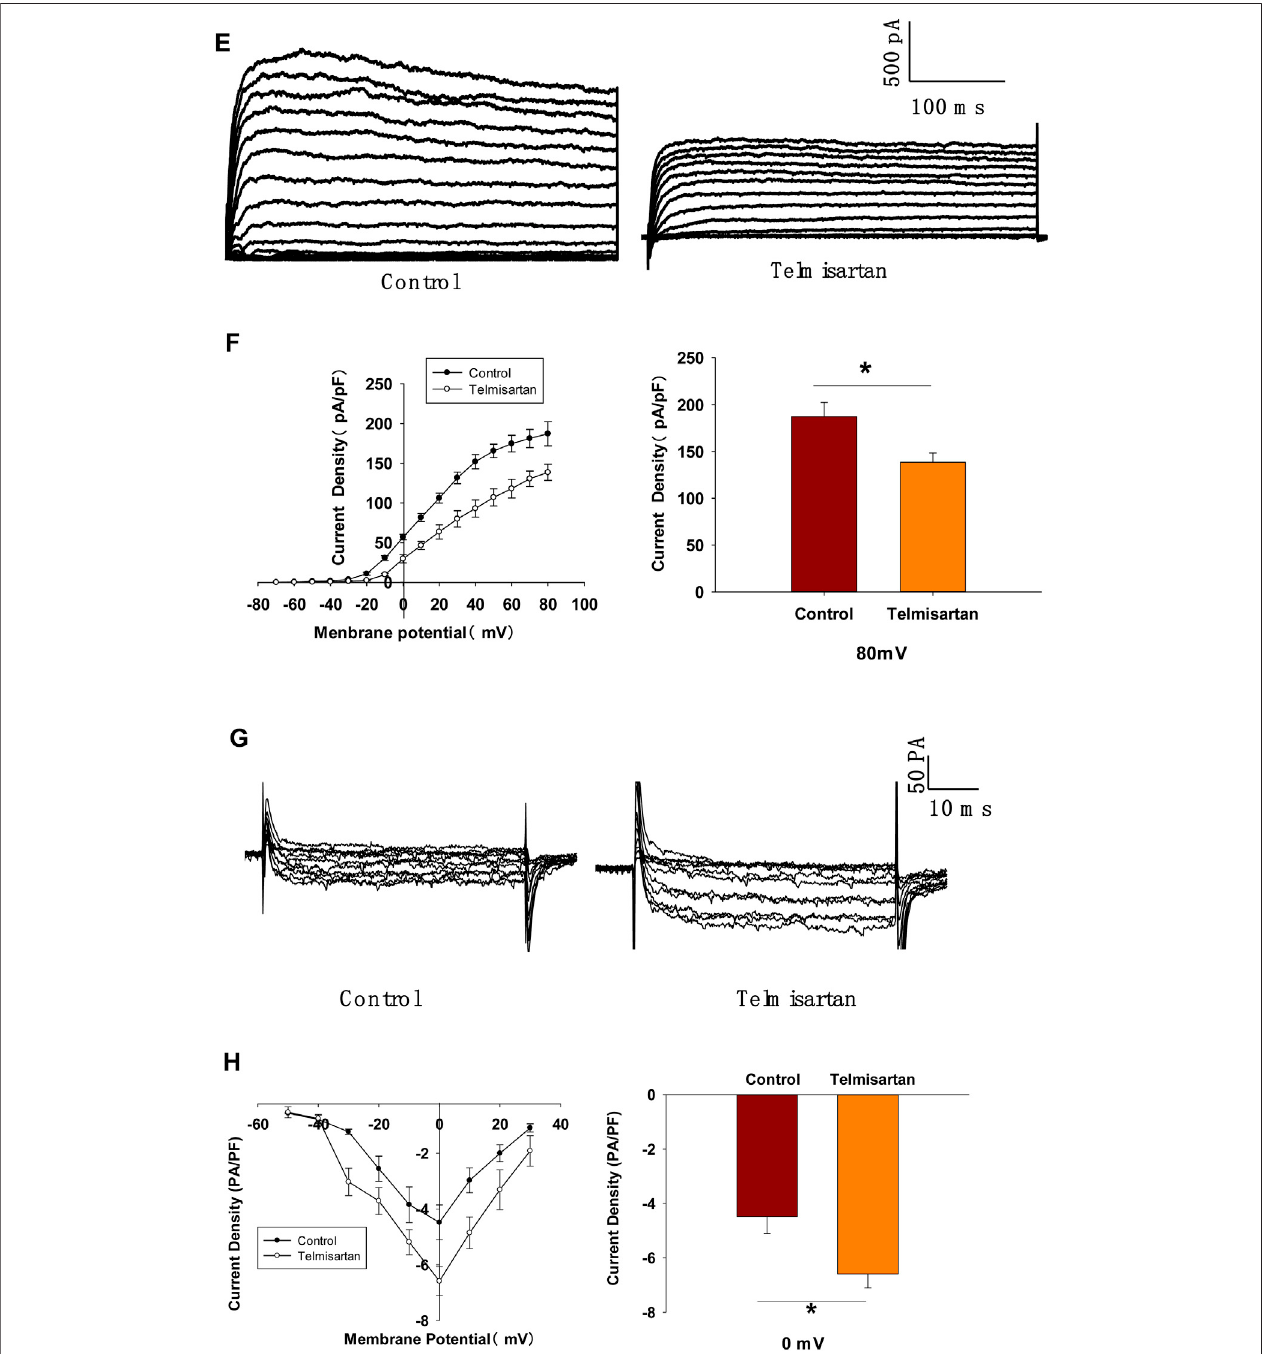
FIGURE8| currentdensityrecordedat0 mVdepolarization(control, n (cid:1) 6cells;telmisartan, n (cid:1) 7cells).In (D) ,alltheisletswereisolatedfromthesamemouse,and the insulin secretion results are normalized to basal secretion at 2.8 Mm glucose concentration. In (E , G) , the cells compared between the groups in each graph are collected from the same animal. All results are reported as the means ± SEM.Statistical differencesbetween two groups were determined using the unpaired two-tailed Student ’ s t testunlessotherwisestated.Glucoselevelsin11-wk-oldmiceatindicatedtimepointswerecomparedusingtheMann – WhitneyRankSumTestexcept at0 min.AUCscalculatedfromthedataofglucoselevelsandplasmainsulinlevelsin11-wk-oldmicewerecomparedusingtheMann – WhitneyRankSumTest.Asforthe insulin assay in (D) , statistical differences among three groups (without telmisartan) were compared using one-way ANOVA and followed by Student – Newman – Keuls method post hoc analysis, and differences between two groups under the same glucose conditions were compared using the paired t test. * p < 0.05.